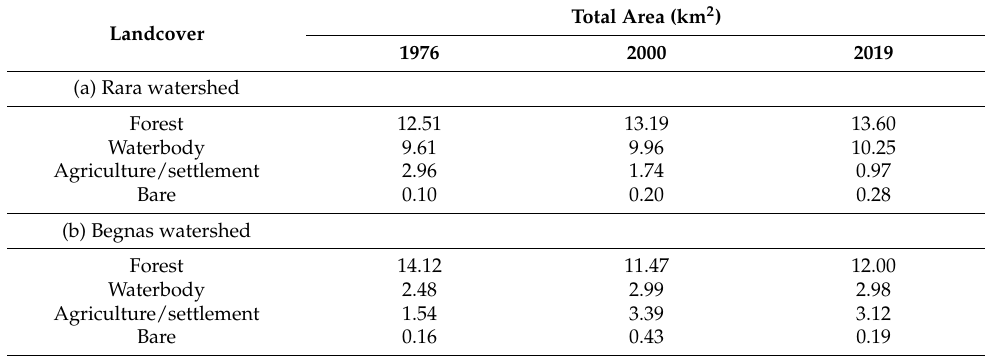
Table 3. Land-cover change of Rara and Begnas Lake watersheds from 1976 to 2019. Landcover